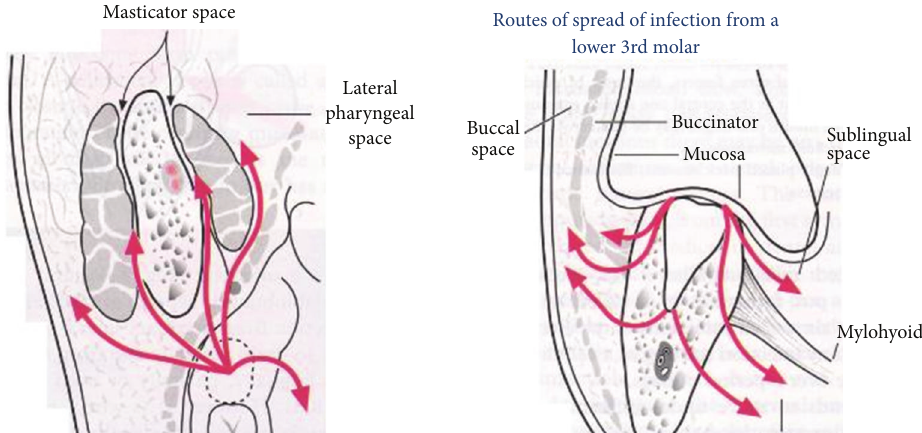
Figure 6: Routes of spread from a lower wisdom tooth. (Taken from http://www.exodontia.info).